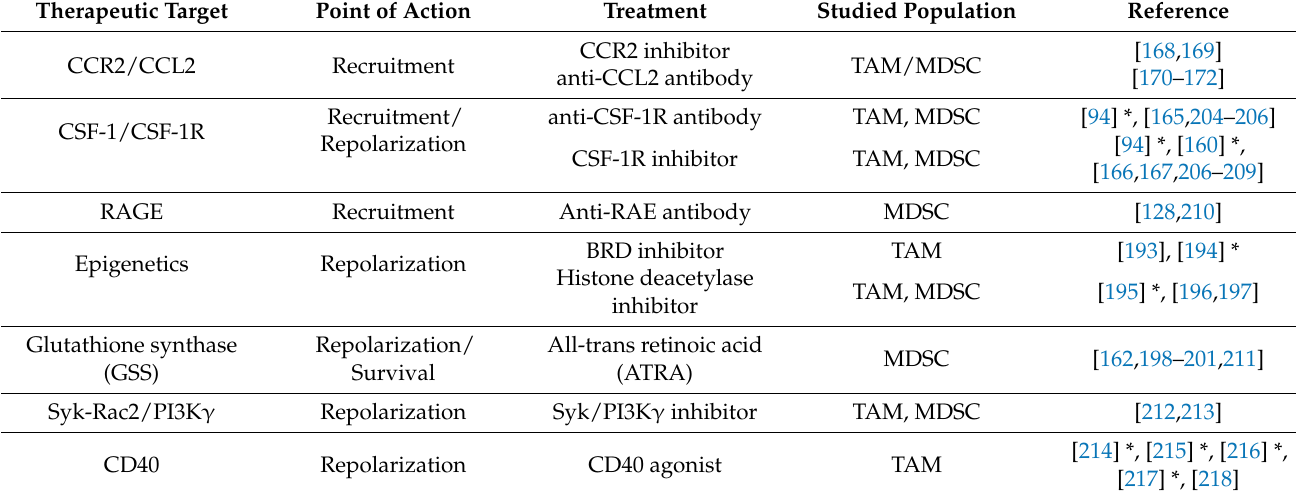
Table 2. Treatment strategies targeting myeloid cells in the tumor microenvironment. Table indicates way of action, therapeutics, the studied myeloid population, and references to publications. Asterisks indicate studies performed in neuroblastoma